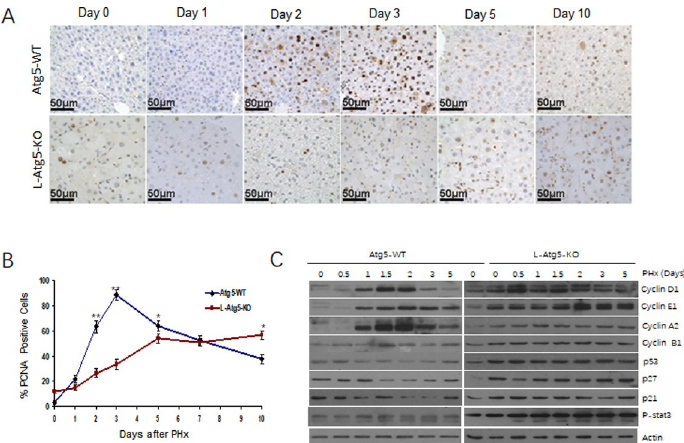
Fig 3. DNA synthesis during liver regeneration is attenuated and delayed in L-Atg5-KO mouse livers. (A) Immunostaining of PCNA at indicated time points after PHx. (B) Percentage of PCNA-positive cells after PHx. The results represented the mean of 20 different viewing fields. The differences between wild-type and L-Atg5-KO mice from day 0 to day 5 and on day 10 were statistically significant ( p < 0.05). (C) Immunoblot analysis of changes in cyclins D1, E1, A2, B1, p53, p27, as well as p21 protein expression levels in Atg5-WT and L-Atg5 KO mice at different time points after 70% PHx. Actin was used as a loading control.